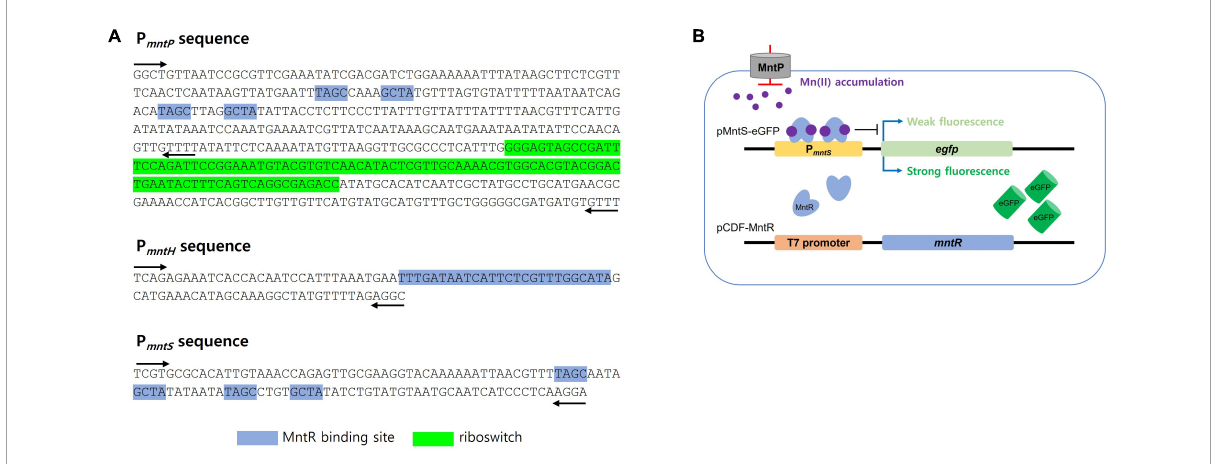
FIGURE1 DNA sequence of promoter regions and the diagram of Mn(II)-sensing Escherichia coli cell-based biosensors. (A) DNA sequences of the promoter regions of mntP, mntH , and mntS . MntR binding sites and the riboswitch region was indicted blue and green highlight, respectively. The black arrows indicated the locations of primers for cloning. (B) The diagram for Mn(II)-sensing E. coli cell-based biosensor harboring pMntS-eGFP. MntR was not tightly bound to P mntS without Mn(II) to induce strong fluorescence, while the signal was weakened with Mn(II) by tight binding of